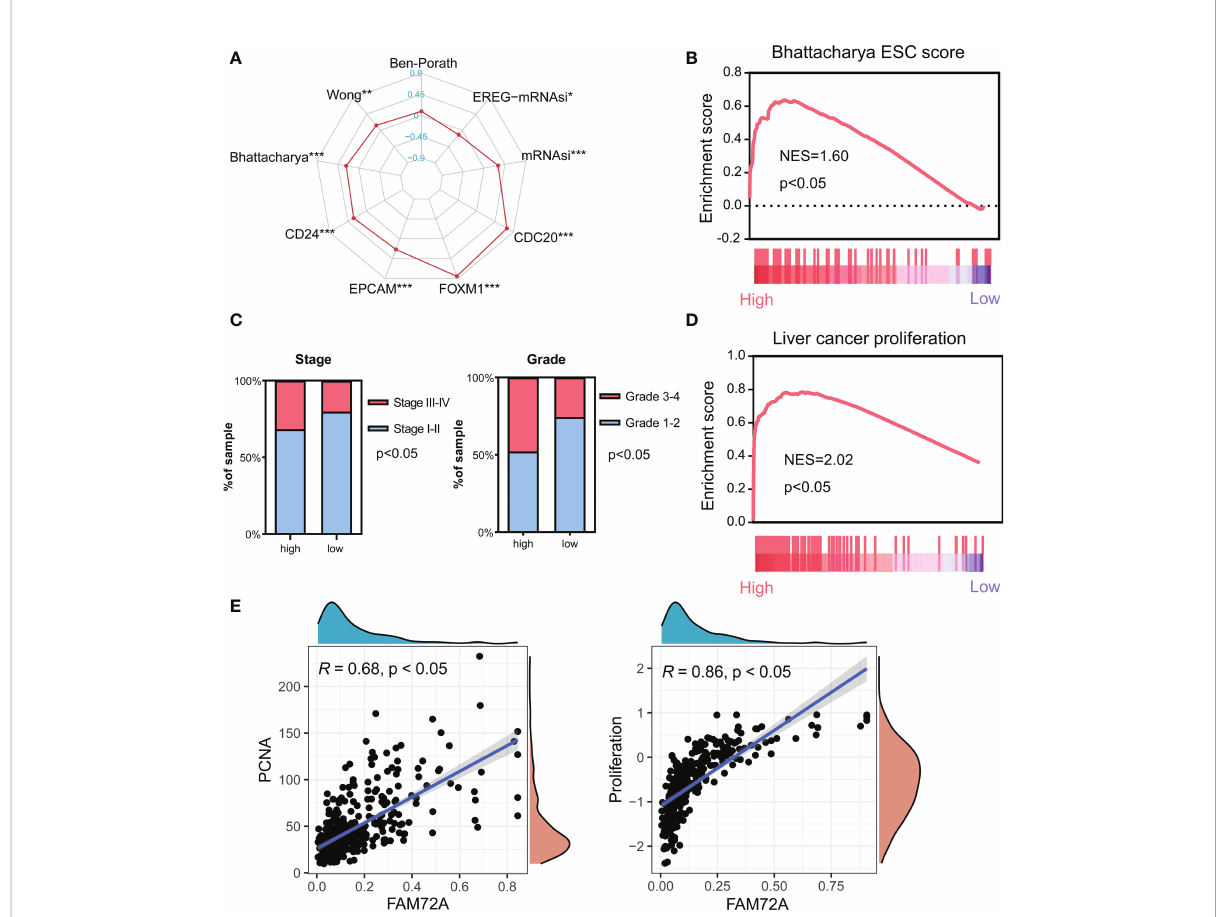
FIGURE 4 Analysis of the effect of FAM72A on stemness in HCC. (A) Radar chart evaluating the relationship between FAM72A expression and the stemness signatures. Statistical analyses were performed using the Spearman correlation test. (B) The signi fi cant enrichment of high FAM72A expression and the Bhattacharya signature analyzed using GSEA. (C) Comparison of the frequency of stages and grades between the high and low FAM72A expression groups. Statistical analyses were performed using the Chi-square test. (D) Signi fi cant enrichment of high FAM72A expression and the proliferation signature. (E) Correlations between FAM72A mRNA expression and both PCNA mRNA levels and proliferation scores. Statistical analyses were performed using the Spearman correlation test. HCC, hepatocellular carcinoma; GSEA, gene set enrichment analysis. *p < 0.05, **p < 0.01, and ***p <